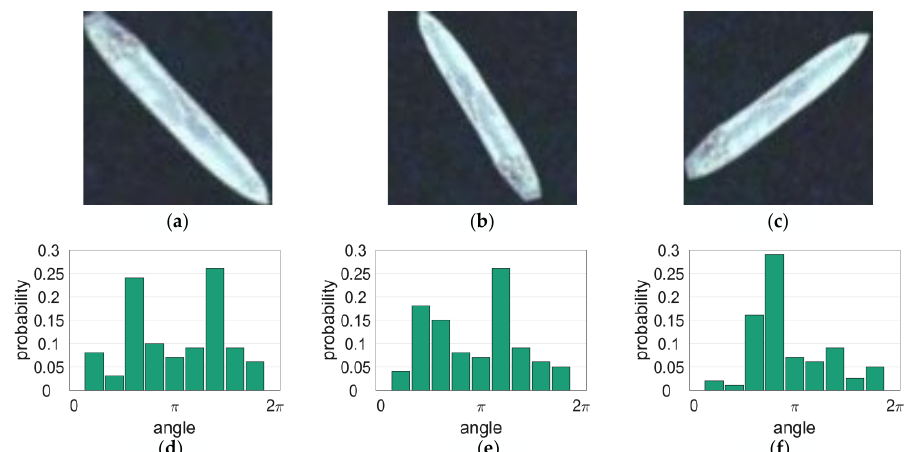
Figure 6. The demonstration of the HOG with different rotation. ( a ) The original image; ( b ) The target rotated 20 ◦ (20 ◦ is an integer multiple of the bin); ( c ) The target rotated at a random angle; ( d – f ) The corresponding demonstrations of HOG feature. It is obvious that cyclic shift is in progress from ( d , e ), while ( f ) shows the complex and irregular gradient change.